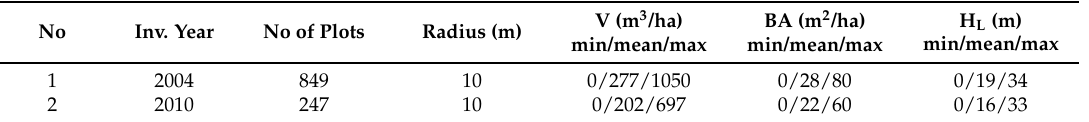
Table 1. Field inventories of training plots used for the development of predictive models estimating the state of the target variables from the remote sensing data.